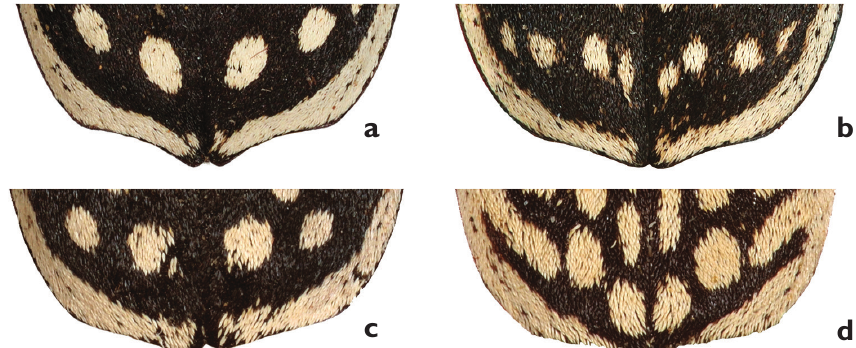
Figures 7. Apical section and apices of elytra: a Apical sinuation strongly developed, apex protruded, almost rectangular, only slightly rounded at most distant tip ( G. rotundatus ) b Apical sinuation developed, apex slightly protruded, strongly rounded ( G. luctuosus ) c Apical sinuation slightly developed to straight, apex not protruberant, broadly rounded, especially on the median side ( G. multiguttatus ) d Apical sinua- tion and apex almost indistinct ( G. minutus goryi